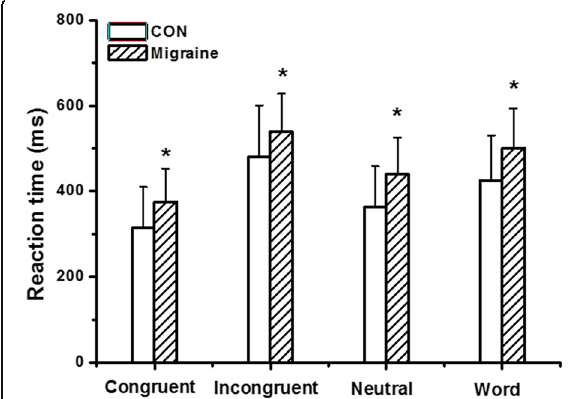
Fig. 2 The reaction time during different conditions. Both the migraine and control group showed the longest reaction time linked to incongruent tasks and the shortest to congruent tasks, and the migraine group had a longer total reaction time compared to the control group under each condition